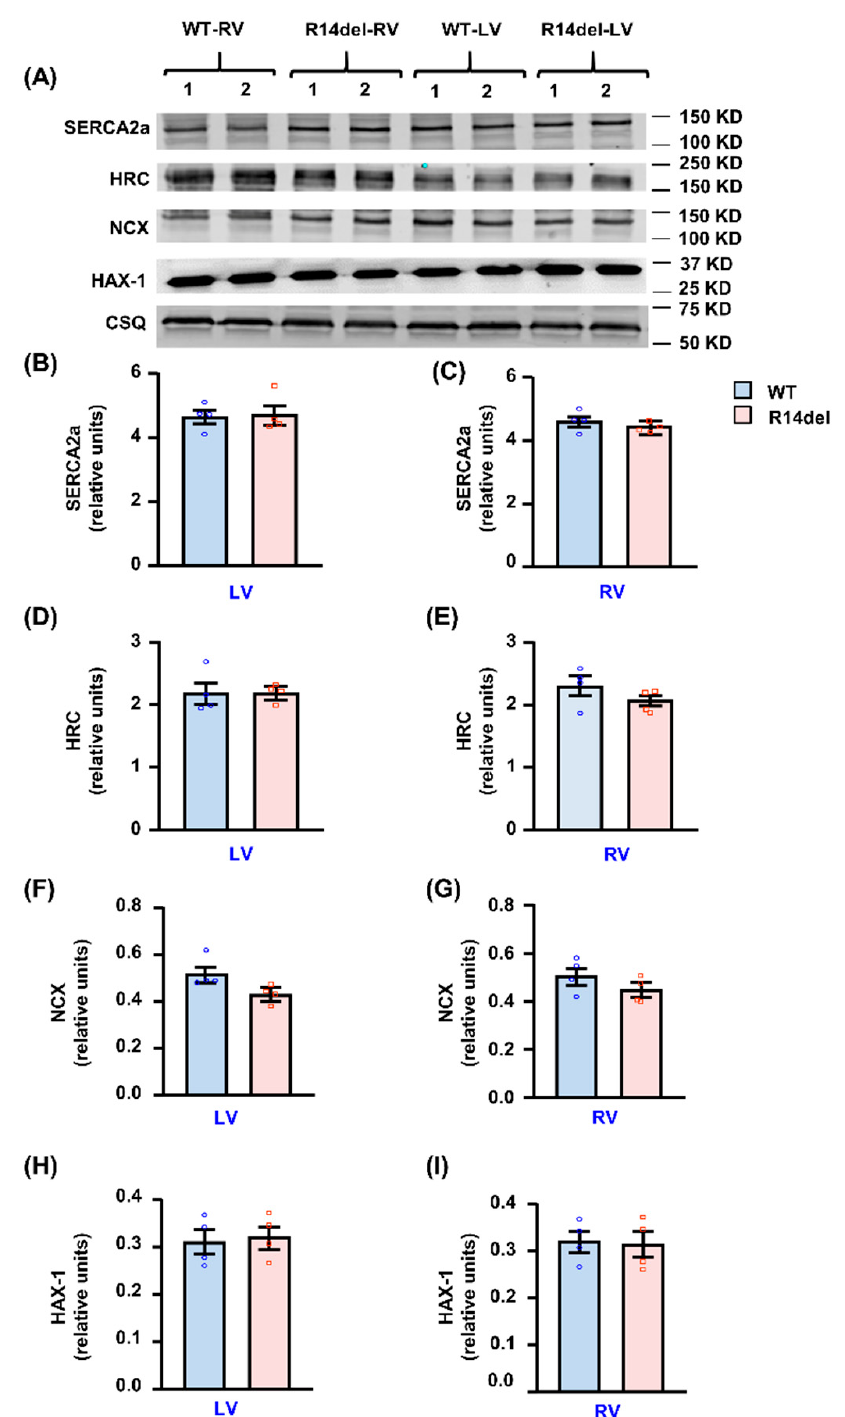
Figure 8. Assessment of SR calcium cycling protein levels in RV and LV of WT and R14del-PLN mice. ( A ) Representative immunoblots of Ca cycling protein levels in WT and R14del ventricles. ( B , C ) Quantitative assessment of SERCA2a protein levels. ( D , E ) Quantitative assessment of HRC protein levels. ( F , G ) Quantitative assessment of NCX protein levels. ( H , I ) Quantitative assessment of HAX-1 protein levels. Calsequestrin (CSQ) was used as a loading control. N = 4 RV and LV samples from WT and N = 4 RV and LV samples from R14del-PLN mice. Twelve- to fourteen-week-old male mice were used. Data are expressed as mean ± SEM for the number of hearts and statistical analyses were performed by two-tailed unpaired t -test. A p -value of <0.05 was considered statistically significant.